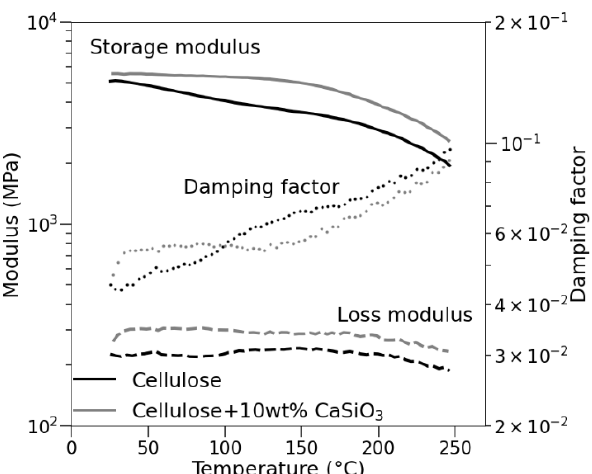
Figure 6. Temperature scan of films made of cellulose only ( black ) and cellulose with 10 wt% CaSiO 3 ( grey ). The storage modulus ( solid ), the loss modulus ( dashed ) and the damping factor ( dotted ) are plotted versus temperature.